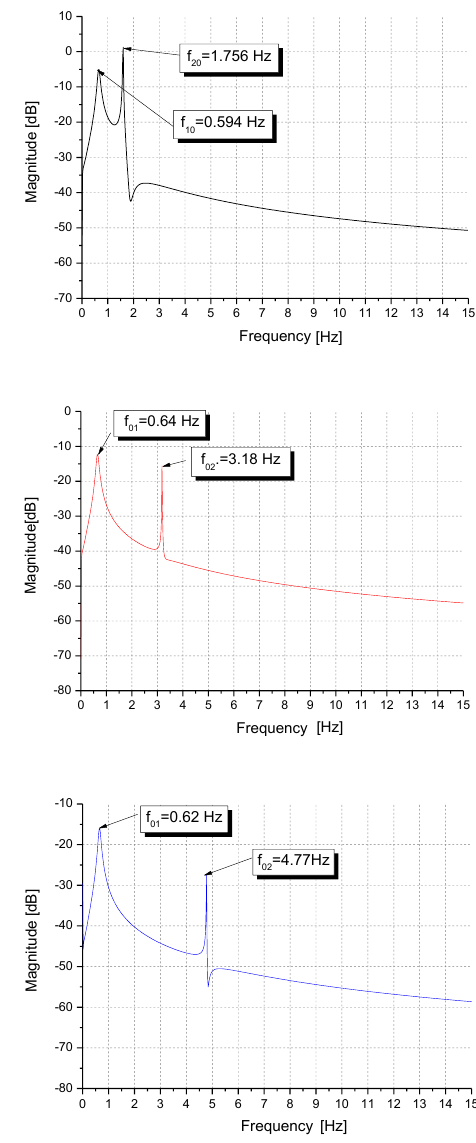
Fig. 4 Frequency response of the air –spring model: f 0 1